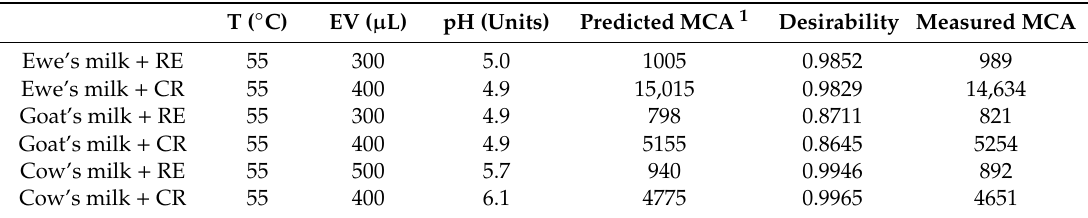
Table 5. Optimal conditions for milk